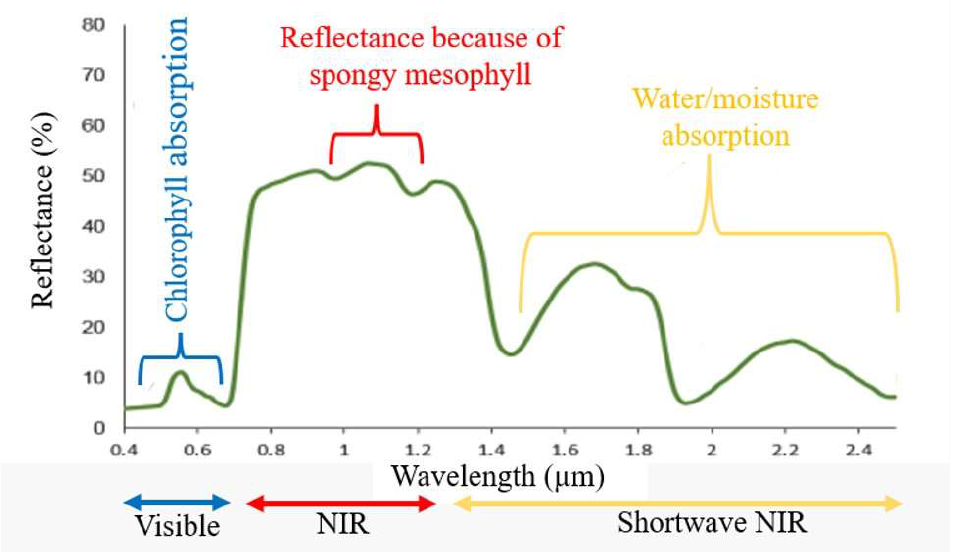
Figure 1. Different spectral reflectance curves for vegetation, modified from [15]. The main absorption and reflectance characteristics are represented.